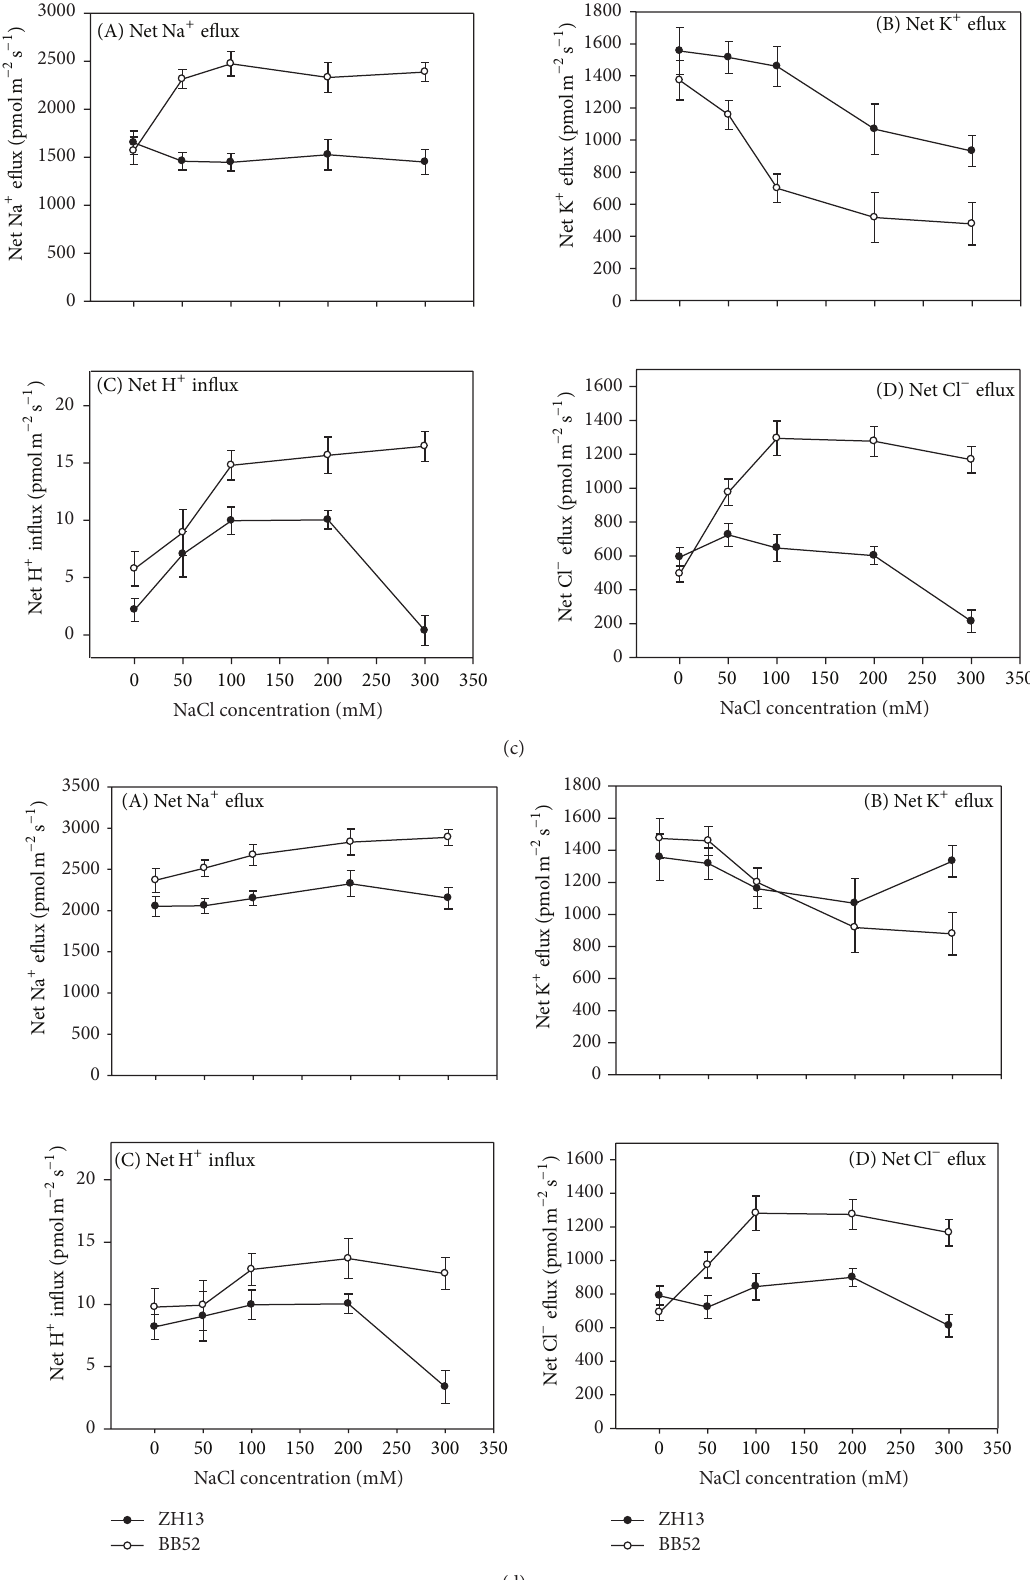
Figure 4: (a) Schematic diagram of noninvasive microtest technique (NMT); (b) typical flux pattern of Na + , K + , H + , and Cl − ; (c) the situation of ion fluxes in young seeding under salt stress; (d) the situation of ion fluxes in mature seedling under salt